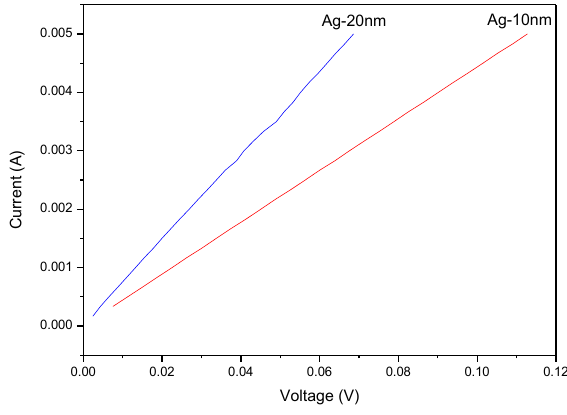
Figure 10. Current-voltage characteristics of single-layer Ag film.